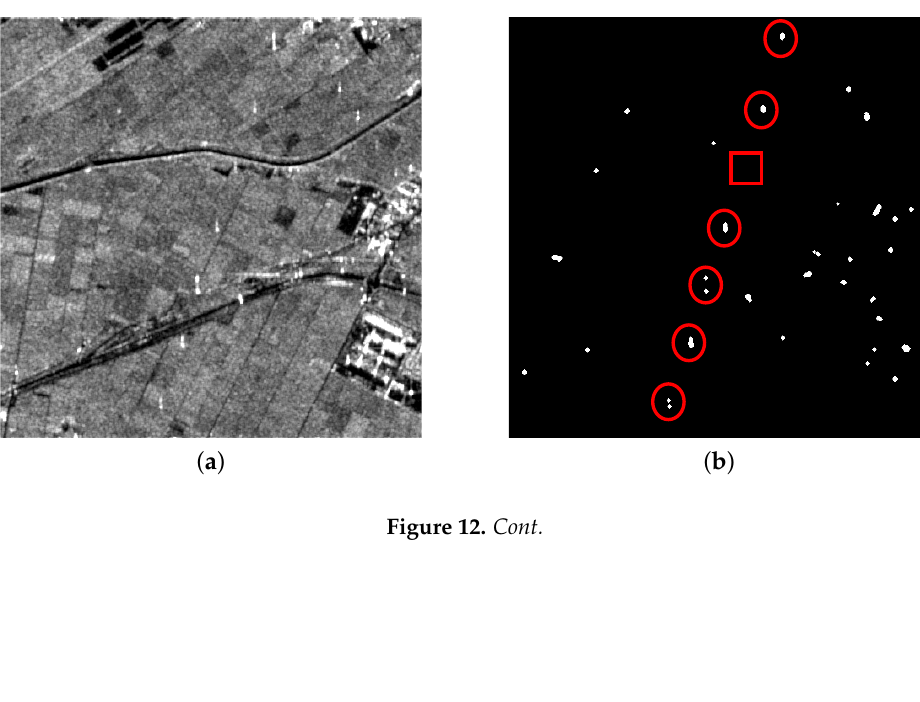
Figure 11. ( a ) filtered image based on PWF; and ( b ) point-like target detection results.